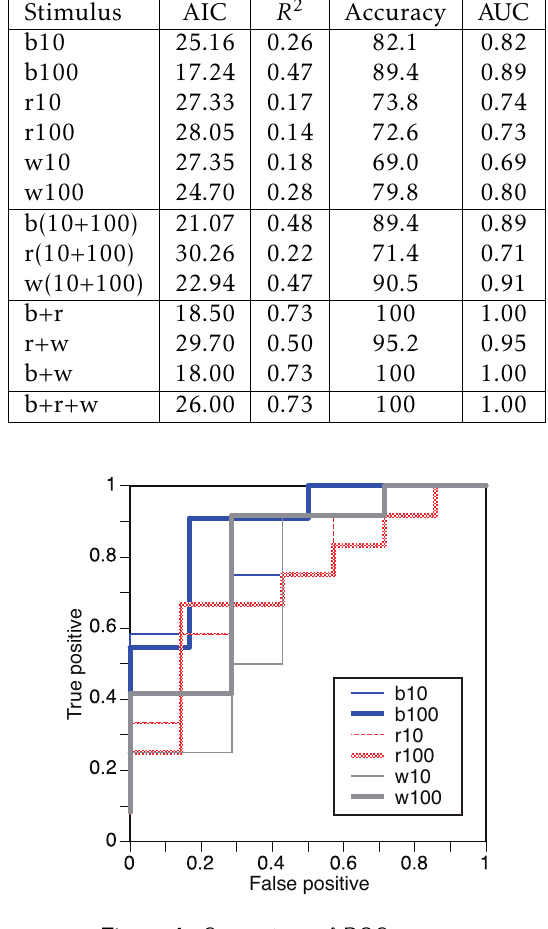
Figure 4. Comparison of ROC